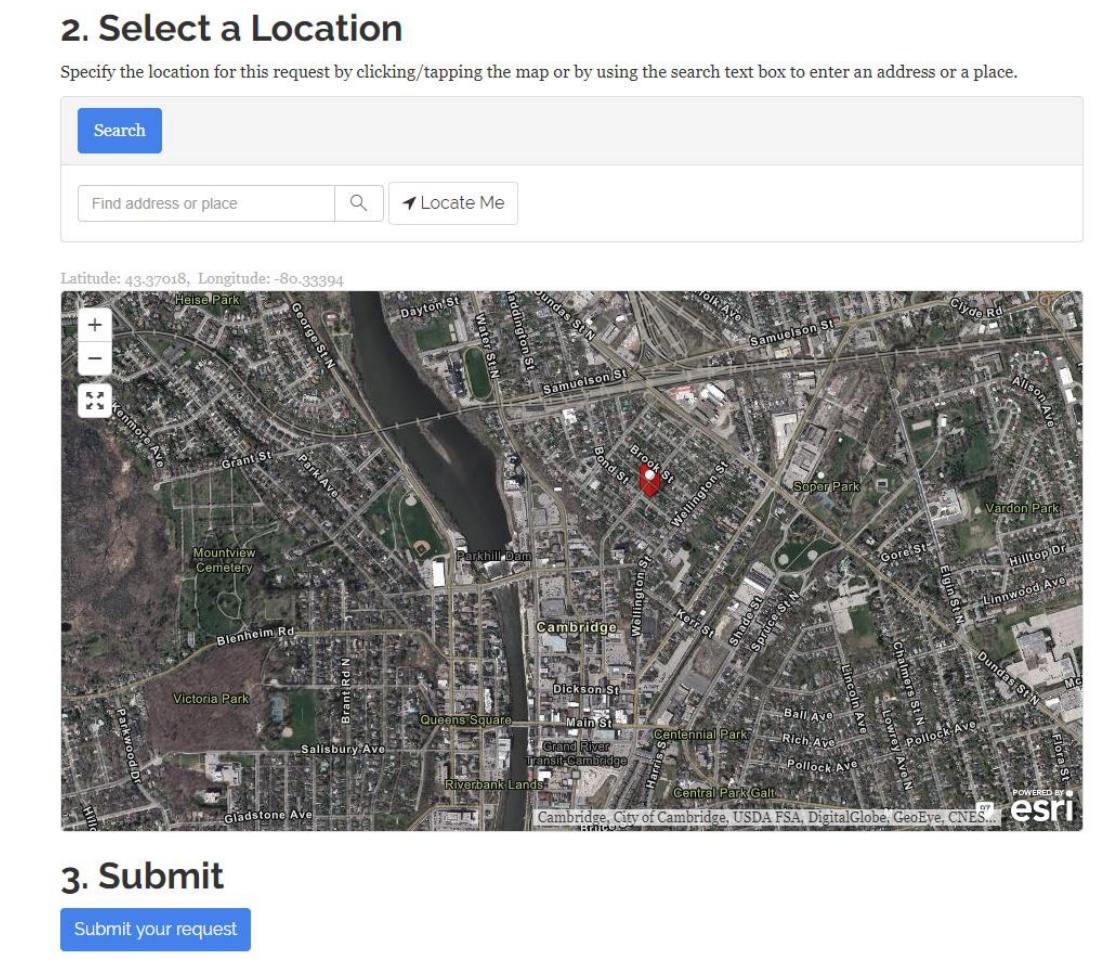
Figure 1: The reporting platform of the City of Cambridge for needles or other hazardous